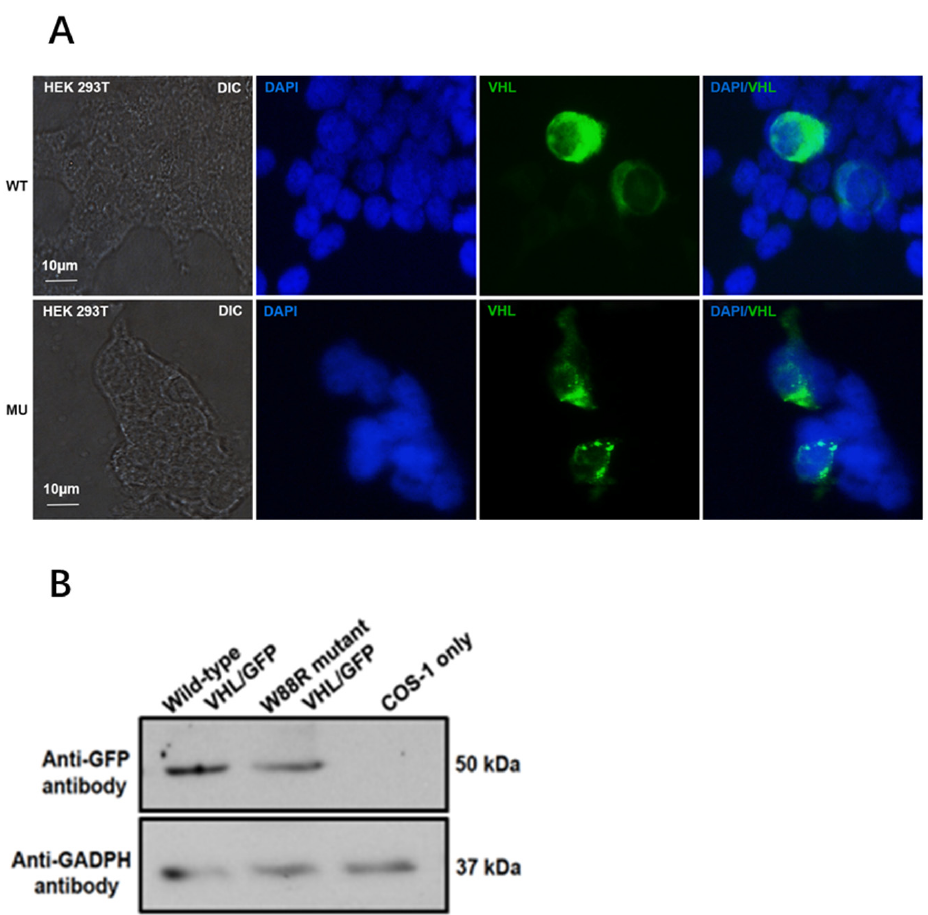
Figure 4. VHL mutation (p.Try88Arg) changes the intracellular localization and protein level. ( A ). Confocal microscopy shows the intracellular localization of GFP-pVHL (WT) and GFP-pVHL (p.Try88Arg) in HEK293 cells. The targeted plasmids were transfected into HEK293 for 24 h, and the cells were counterstained with DAPI. The cells were then washed three times and used for imaging. GFP-pVHL (green); DAPI (blue). ( B ). Western blot analysis showed a reduced VHL protein level in HEK293 cells transfected with the VHL mutant expression vector.